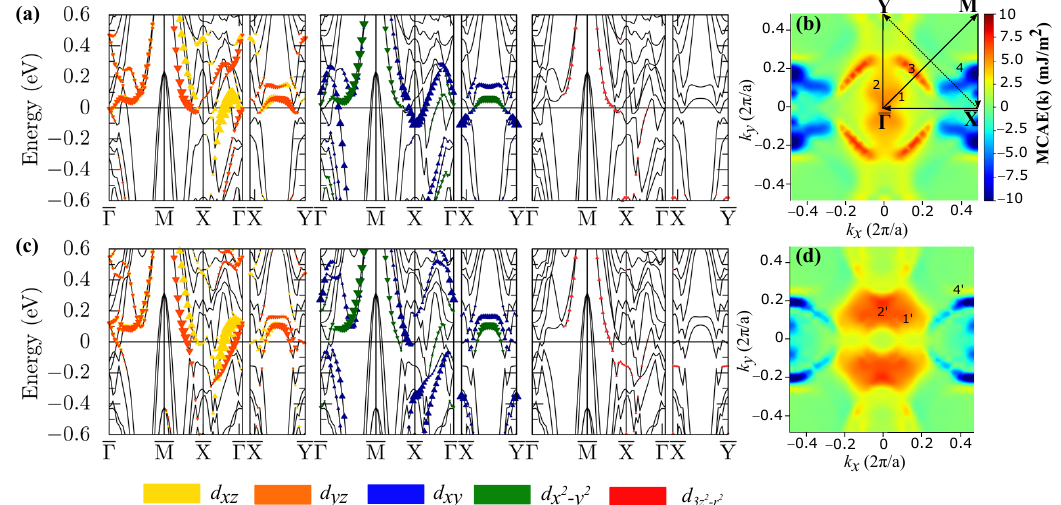
Figure 4. ( a , b ) Band dispersion curves of Fe 1 for d -orbitals minority-spin states (results without SOC) and atomic k -resolved MCAE of Fe 1 for structure-I. ( c , d ) Same as ( a ) and ( b ) for the structure-II. The labels of 1, 2, 3, 4, 1’, 2’, and 4’ on ( b ) and ( d ) are explained in text. The three panels in ( a ) and ( c ) indicate the projected component of d -orbitals ( d xz , d yz ), ( d xy , d x 2 structure and its magnitude of symbols indicates the corresponding weights of the d